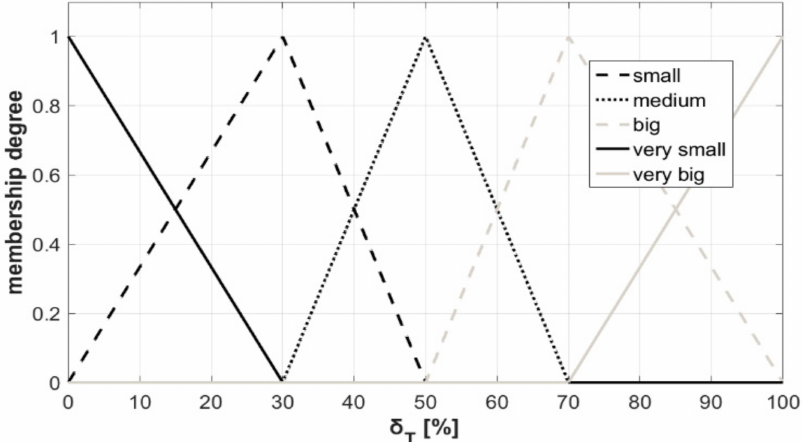
Figure 12. Membership degree of the output variable throttle lever position δ T associated with fuzzy sets: very small, small, medium, big, very big.